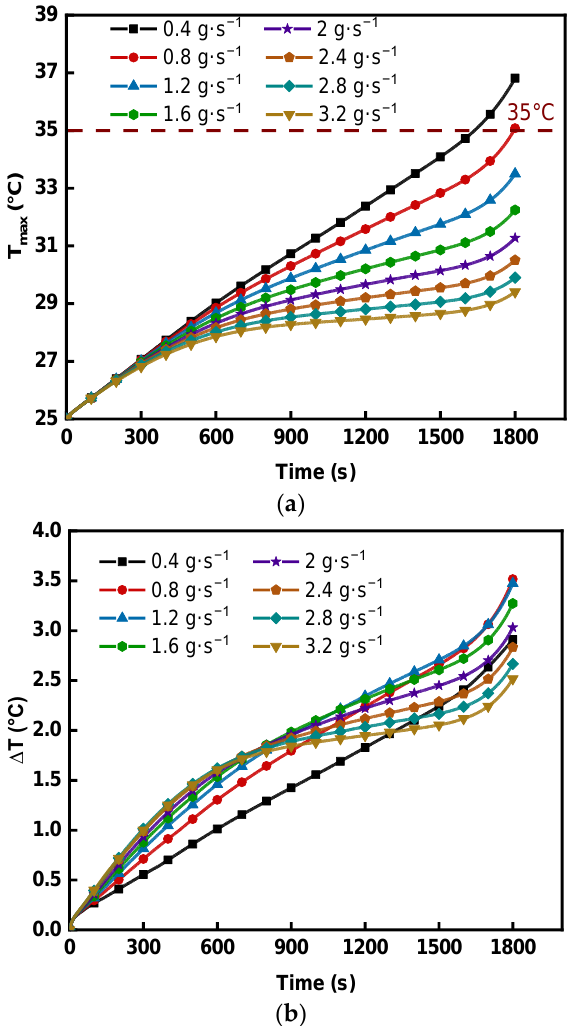
Figure 8. Effect of fluid flow rates on: ( a ) maximum temperature T max ; ( b ) maximum temperature difference D T of battery module.